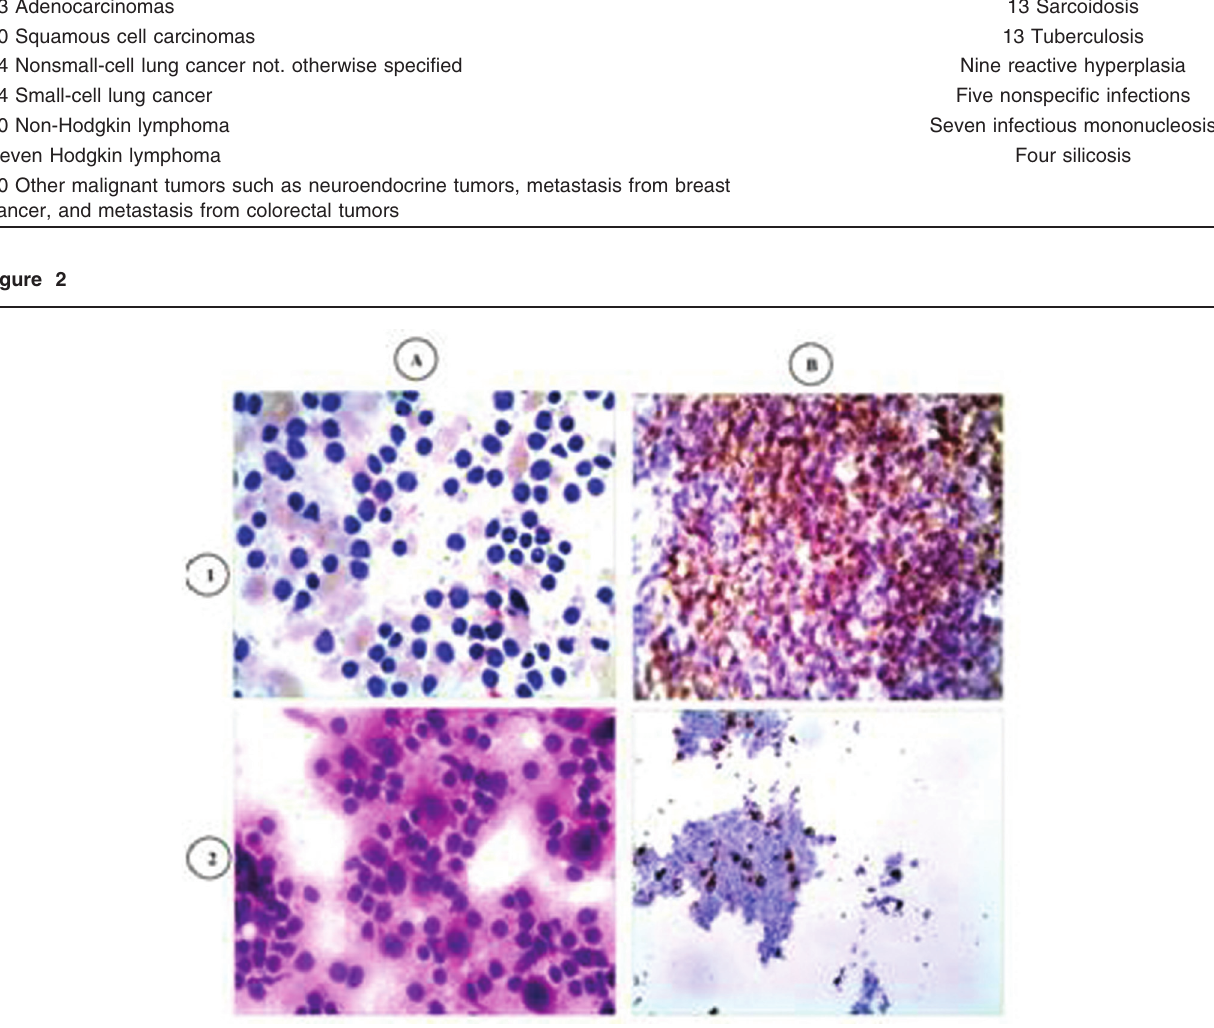
Table 2 Final diagnosis of different mediastinal lesions Malignant lesions ( N =